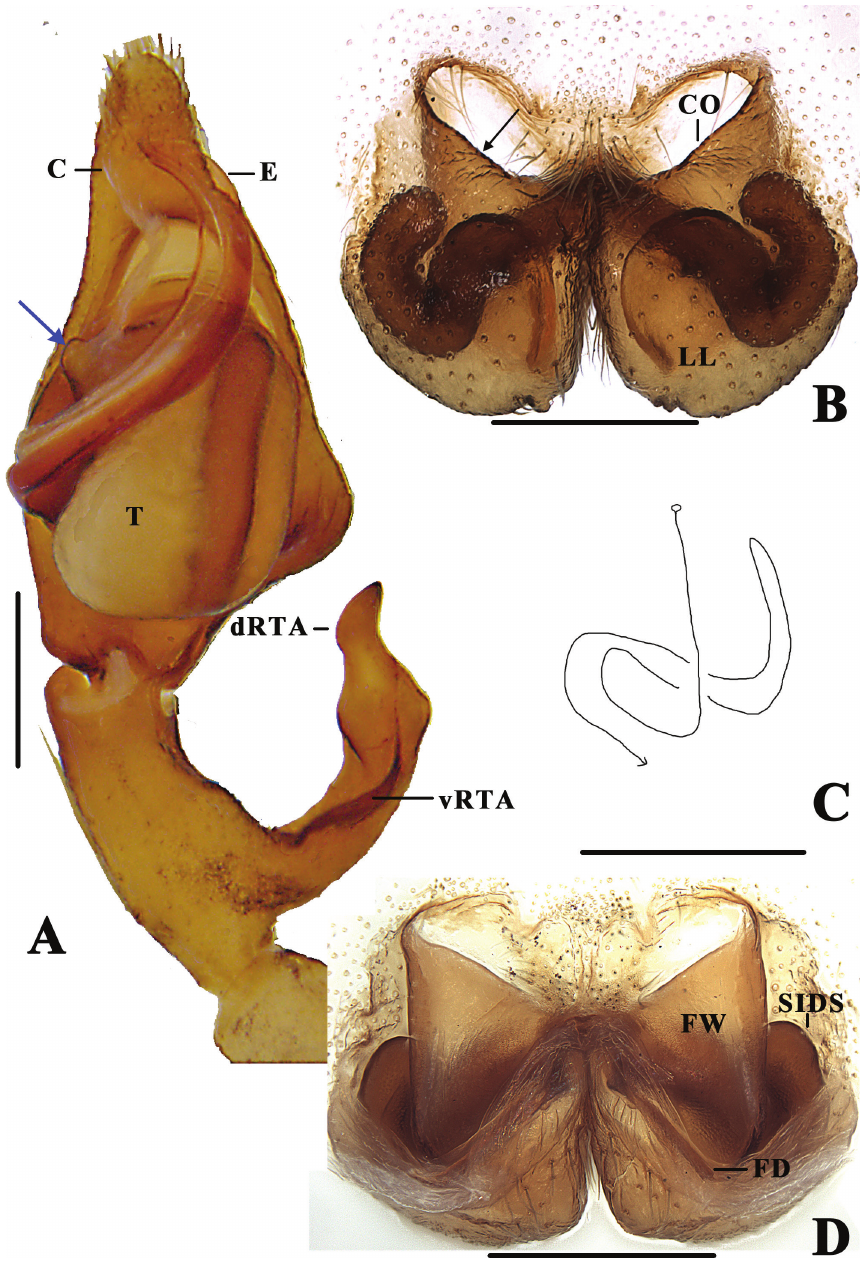
Figure 2. Pseudopoda bibulba Xu & Yin, 2000 A left male palp, ventral B epigyne, ventral C schematic course of internal duct system in right part, dorsal D vulva, dorsal. Black arrow pointing to anterior margin of lateral lobe, blue arrow to tegular outgrowth. Abbreviations: C–conductor; dRTA–dorsal retrolateral tibial apophysis; E–embolus; vRTA–ventral retrolateral tibial apophysis; T–tegulum; CO–copulatory opening; LL–lateral lobes; FD–fertilisation duct; FW–first winding; SIDS–sclerotised internal duct system. Scale bars: 0.5